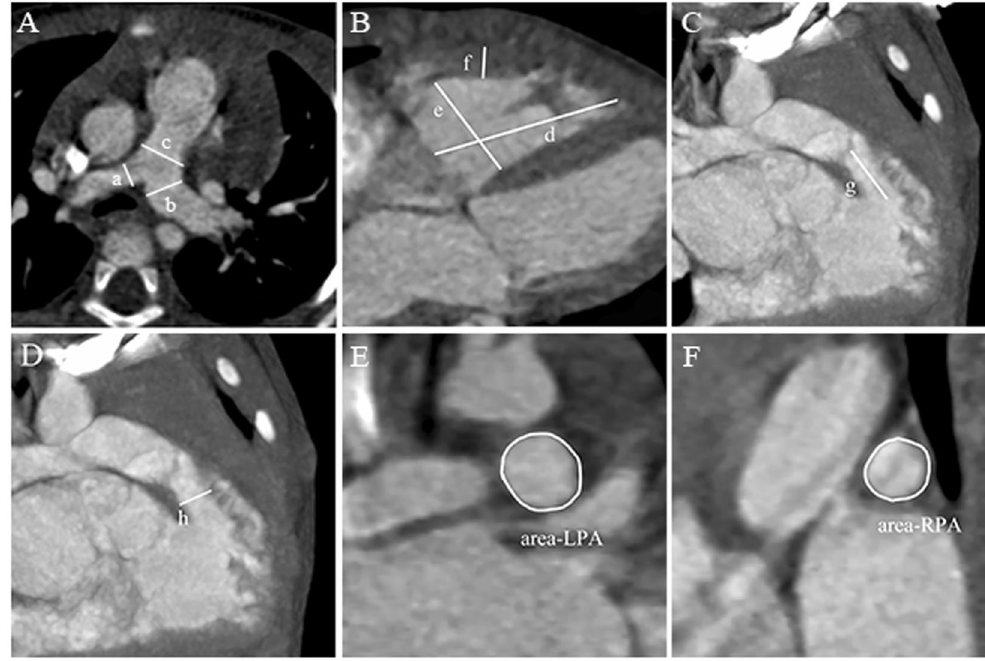
Figure 2. Measurements of pulmonary artery and right ventricle. Measurements of pulmonary artery ( A ): PRA diameter (D_ rpa), LPA diameter (D_ lpa), and MPA diameter (D_ mpa) were assessed on the DSCT at the level of the pulmonary artery bifurcation. The size of RV was measured from the four-chamber view ( B ). The RVOT length (L-rvot) and RVOT diameter (D_rvot) were measured from the anterior aortic wall above the aortic valve to the pulmonary valve ( C , D ). The cross-section areas of LPA and RPA were measured at the first branching point of each artery ( E , F